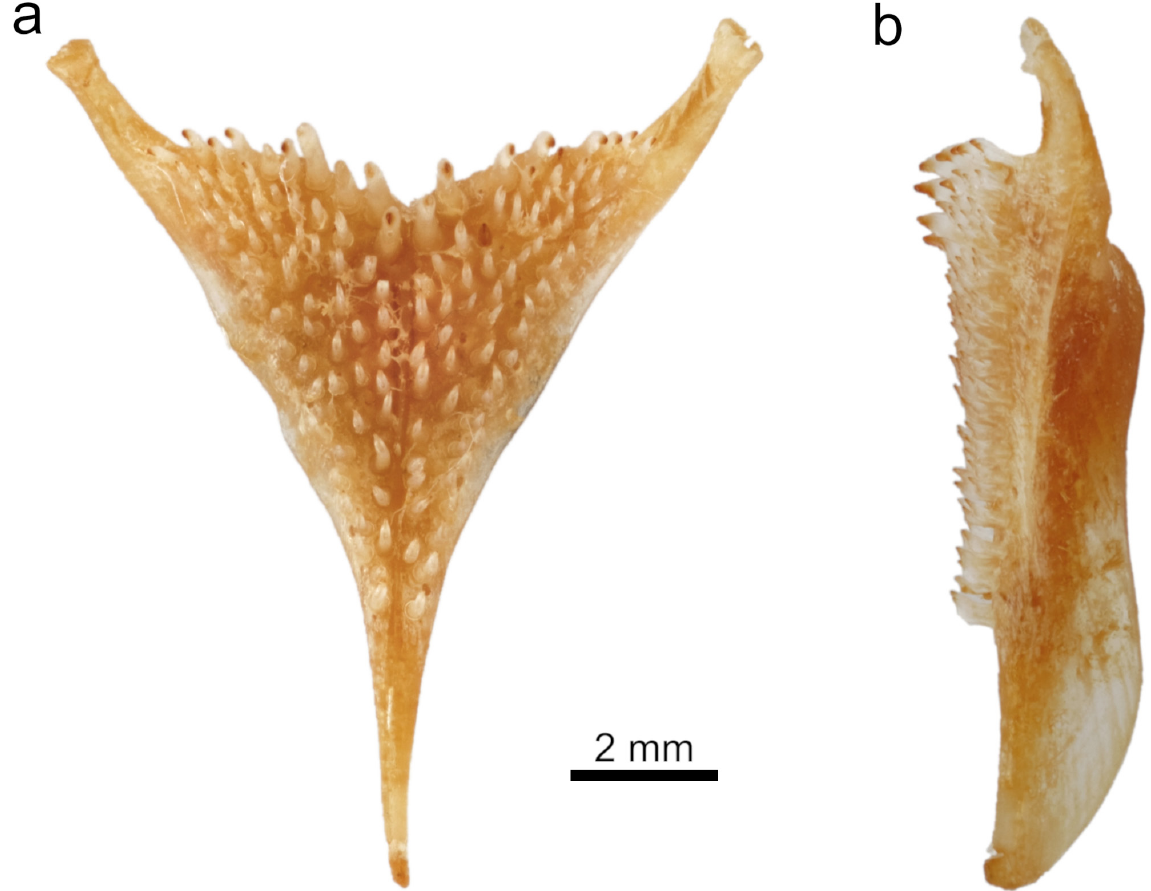
Fig. 16. Haplochromis simba sp. nov. (RMCA 2016.035.P.0223; 105.5 mm SL). a . Dorsal view of the lower pharyngeal jaw. b . Lateral view of the lower pharyngeal